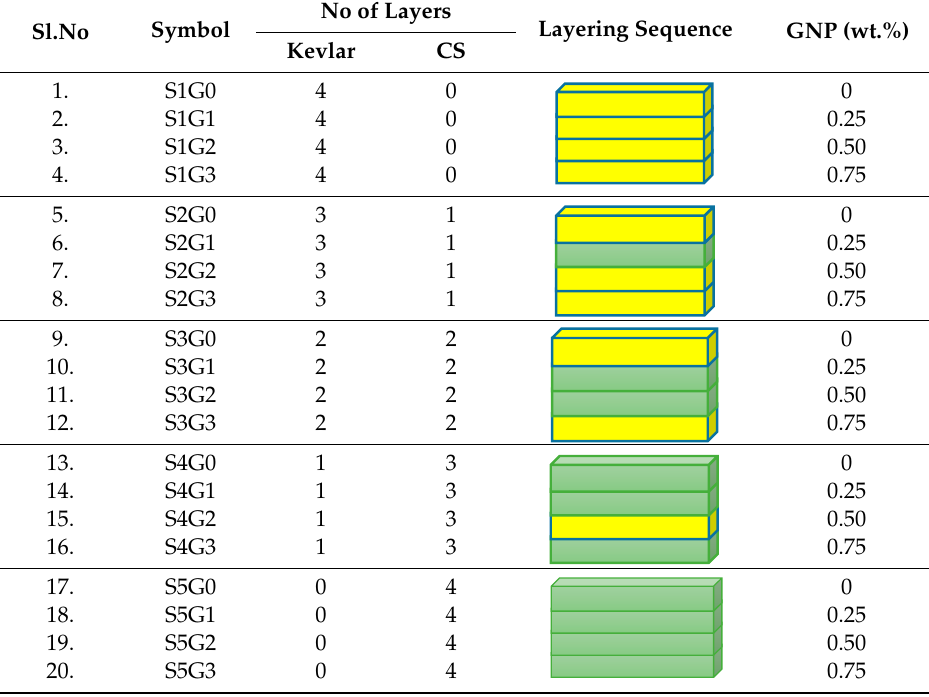
Table 1. Specification and its corresponding layering sequence and GNP